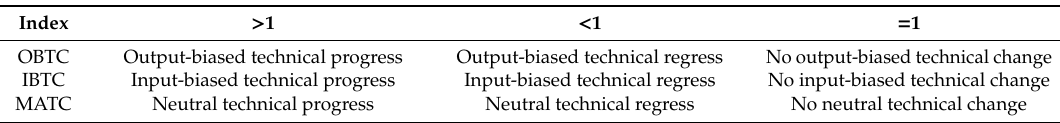
Table 1. Output-biased technical change (OBTC), input-biased technical change (IBTC) and magnitude of technical change